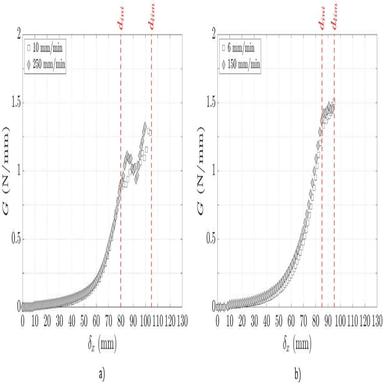
ERR-displacement curves for (a) rigid (T6-01) and (b) flexible (T7-03) bonded joints, tested following the WDT+.